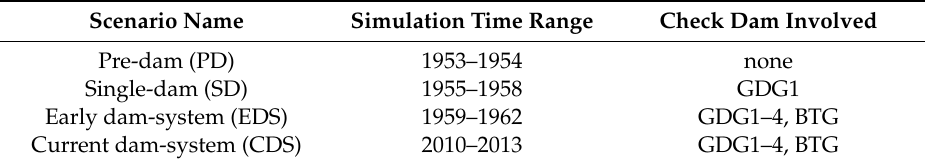
Table 3. Description of the four scenarios in the